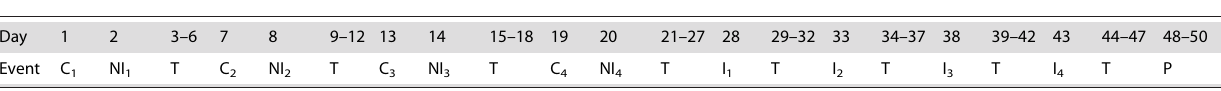
Table 2. Timeline of the different test phases.